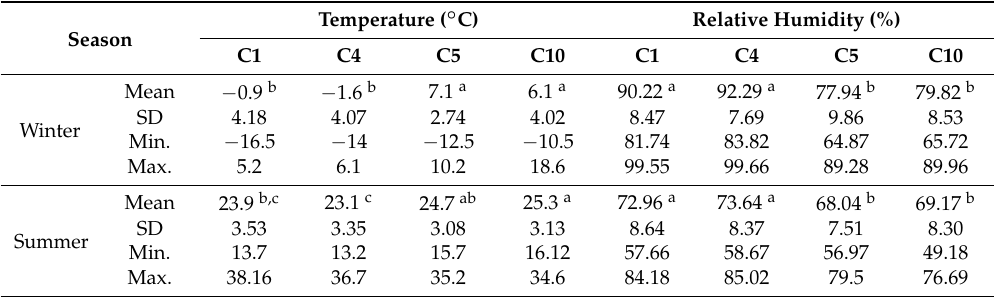
Table 2. Least square means, SD, minimum and maximum values for temperature and relative humidity inside the selected trailer compartments (C1, C4, C5 and C10) during winter and summer.